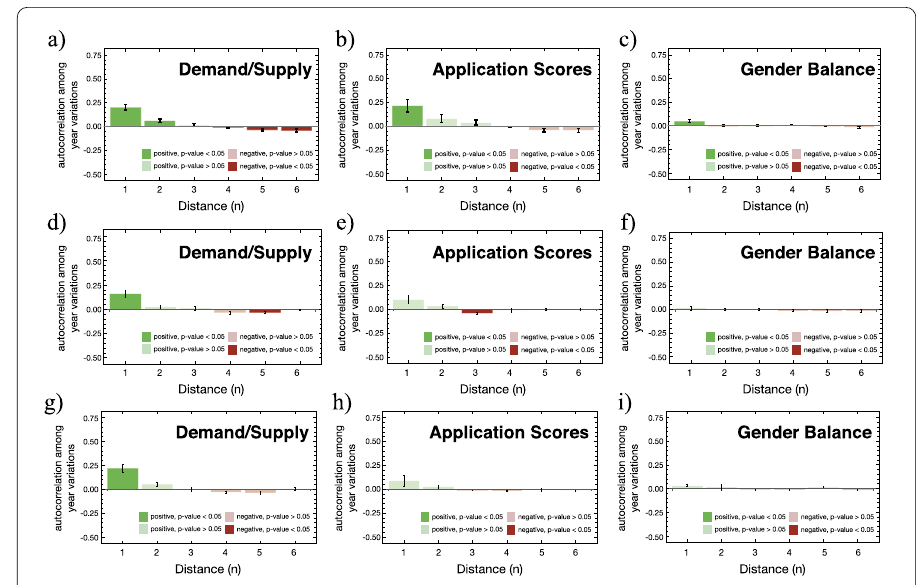
Figure 5 Autocorrelations in respect to the time variations of different features for the PHES ( a )–( c ), CHES between 2006 and 2011 ( d )–( f ), and CHES between 2012 and 2017 ( g )–( i ) networks. Panels show the autocorrelations computed for the temporal variations of demand-supply ratio ( a ), ( d ), ( g ), application scores ( b ), ( e ), ( h ), and gender balance levels ( c ), ( f ), ( i ). We identify positive autocorrelations up to two degree of separation on demand-supply and application scores, the same is not shown in the gender balance. Bars in light colors indicate an autocorrelation that is not significantly different from zero (failed a t -test with p >